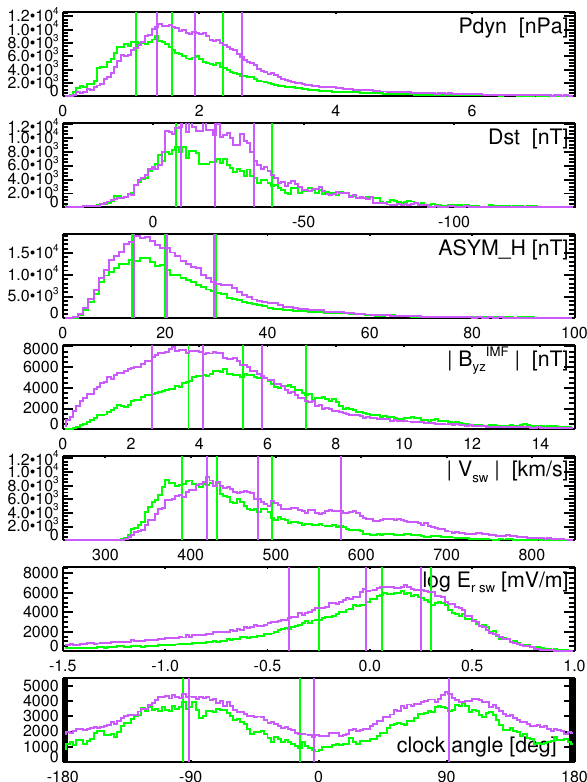
Fig. 1. Solar wind and geomagnetic parameter distribution for the time interval of EDI observations 2001–2006. All data points used for the analysis, i.e., after filtering for stable IMF conditions, are drawn as green lines; the purple lines illustrate the contrasting data set of all those data points that were removed by the filtering. The panels from top to bottom show the dynamic pressure of the solar wind protons, P dyn , at the magnetopause, the Dst index characterizing geomagnetic activity of the ring current, the ASYM-H index which is used here as a proxy of the AE index of auroral geomagnetic activity, the magnitude of the IMF vector components in the GSM y-z-plane, | B IMF yz | , the magnitude of solar wind velocity, | V s.w. | , the solar wind reconnection electric field, E r,sw (see Eq. 3), and finally the IMF clock angle. The vertical lines in each panel indicate the quartiles of the distribution for the corresponding pa-